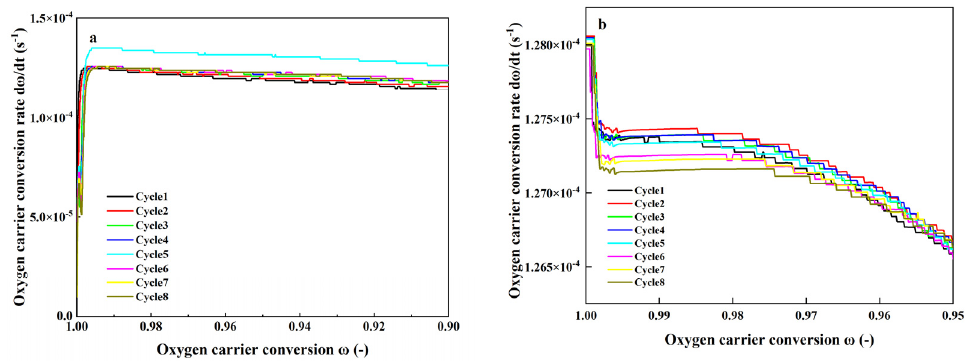
Figure 11. Rate of oxygen carrier conversion during cycles with ( a ) CH 4 and ( b ) CO at 950 °C, and the fuel concentrations were all at